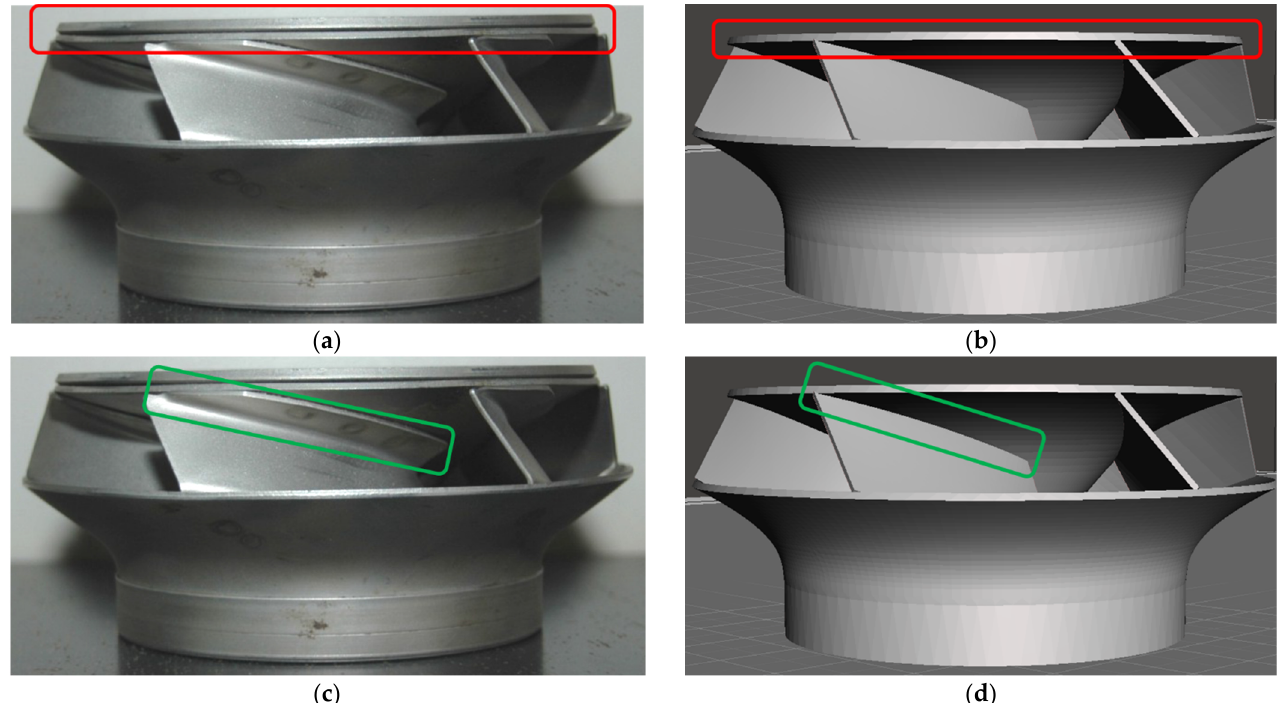
Figure 5. Topographic optimization and modification of the flared parts and blades for improving the resistance of the impeller and guarantee the success of the SLM printing process: ( a , b ) complete filling of the upper flared part; ( c , d ) simplification of the blade hanging by removing the bended flap. Table 3. Main properties of the adopted materials for the finite element analysis. The values reported for the AISI 304 and PET are those suggested by the Autodesk Inventor 2019 software, while for the AISI 316L the typical average values evaluated after the SLM printing process [44] have been accordingly